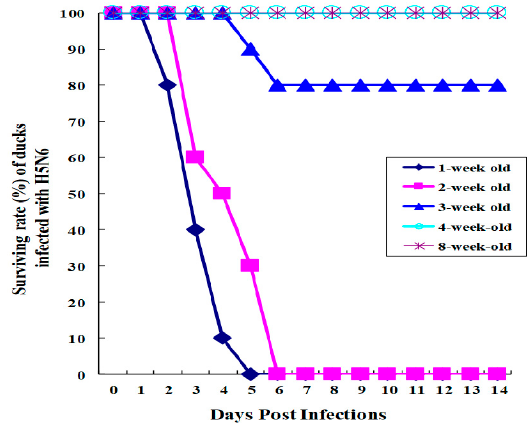
Figure 1. Surviving rate of ducks infected with HP H5N6 avian influenza virus. Ducks aged from 1, 2, 4, or 8 weeks old ( n = 10 per group) were i.n. infected with 0.25 mL of 10 6 EID 50 / mL of A/Waterfowl/Korea/S57/2016 (H5N6) (clade 2.3.4.4.). Duck surviving rate was monitored for 14 days p.i.